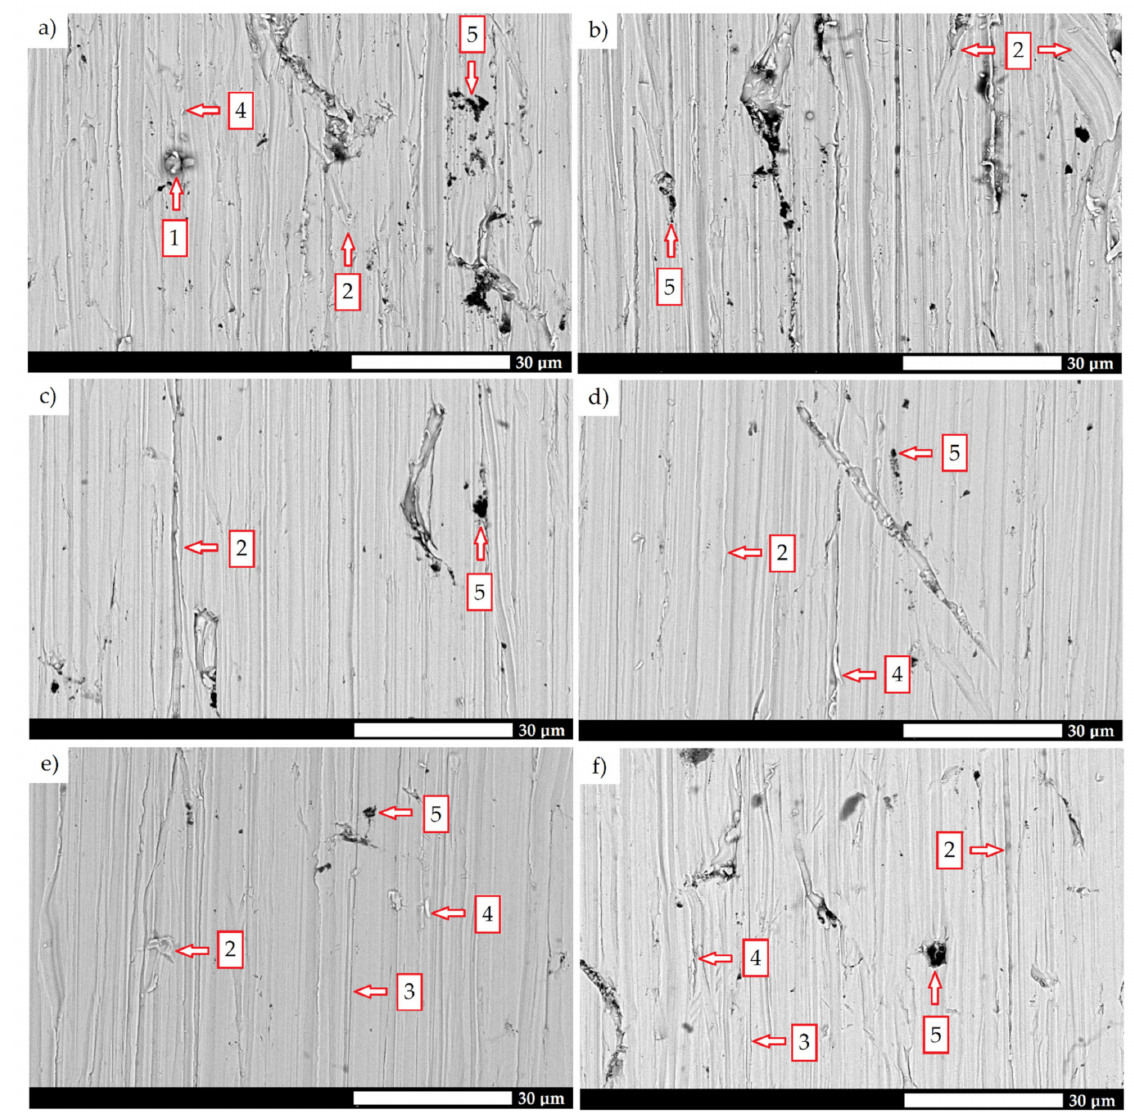
Figure 10. Images of worn surfaces. ( a ) 38GSA (N); ( b ) Creusabro 4800; ( c ) Creusabro 8000; ( d ) TBL PLUS; ( e ) XAR 600; ( f ) 38GSA (HT). 1—abrasive particle, 2—microploughing (furrows), 3—microcutting, 4—wear debris, 5—detached material. SEM,